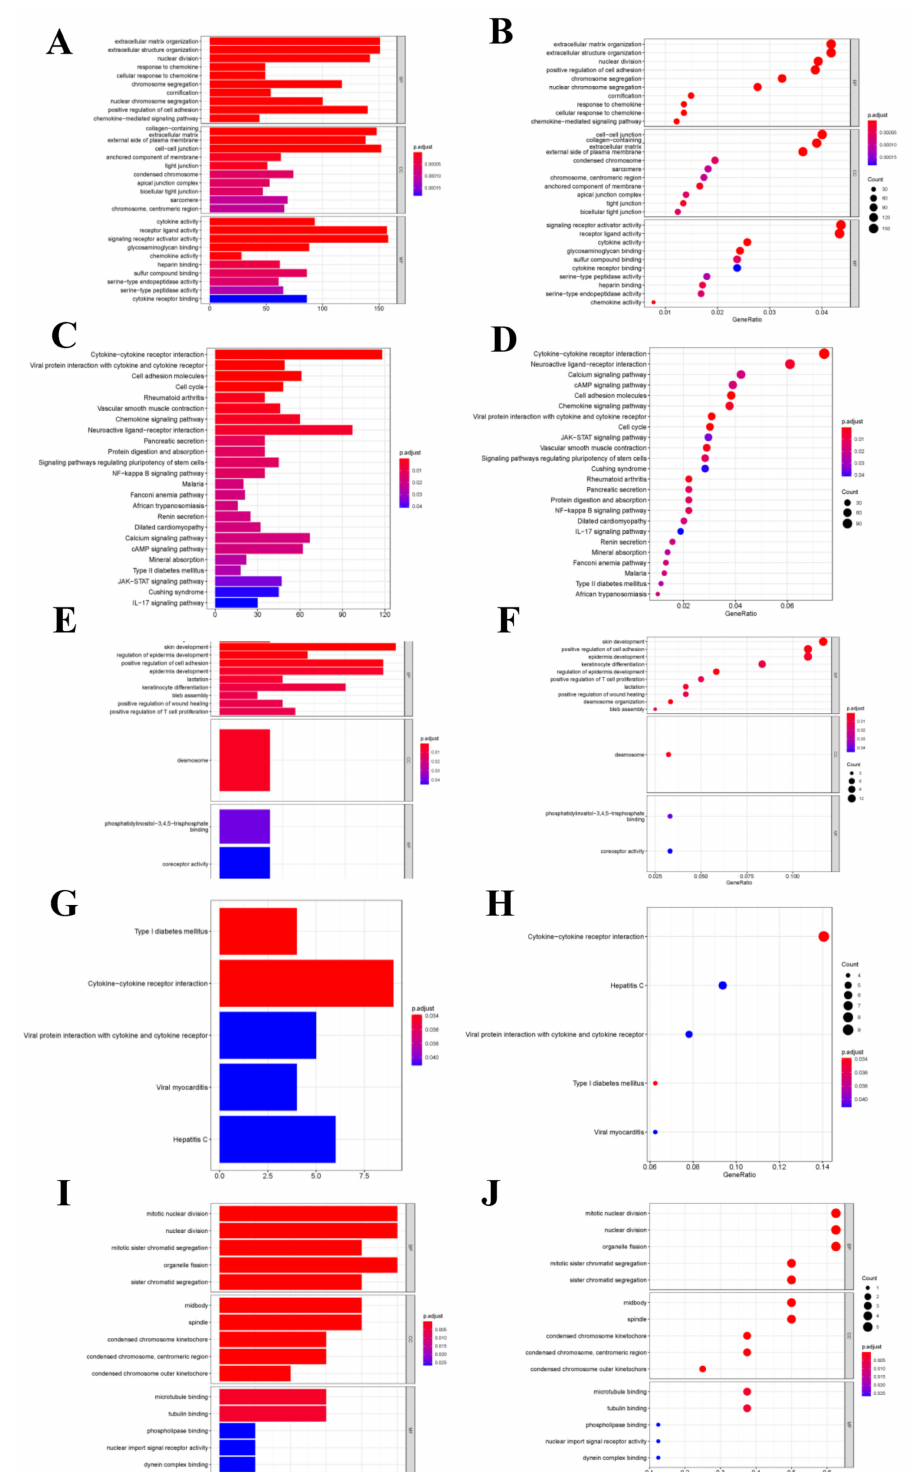
Figure 5. Functional enrichment analysis. ( A , B ) GO function enrichment analysis for differential transcriptome genes. ( C , D ) KEGG pathway analysis for differential transcriptome genes. ( E , F ) GO function enrichment analysis for net-node genes. ( G , H ) KEGG pathway analysis for net-node genes. ( I , J ) GO function enrichment analysis for hub-cluster